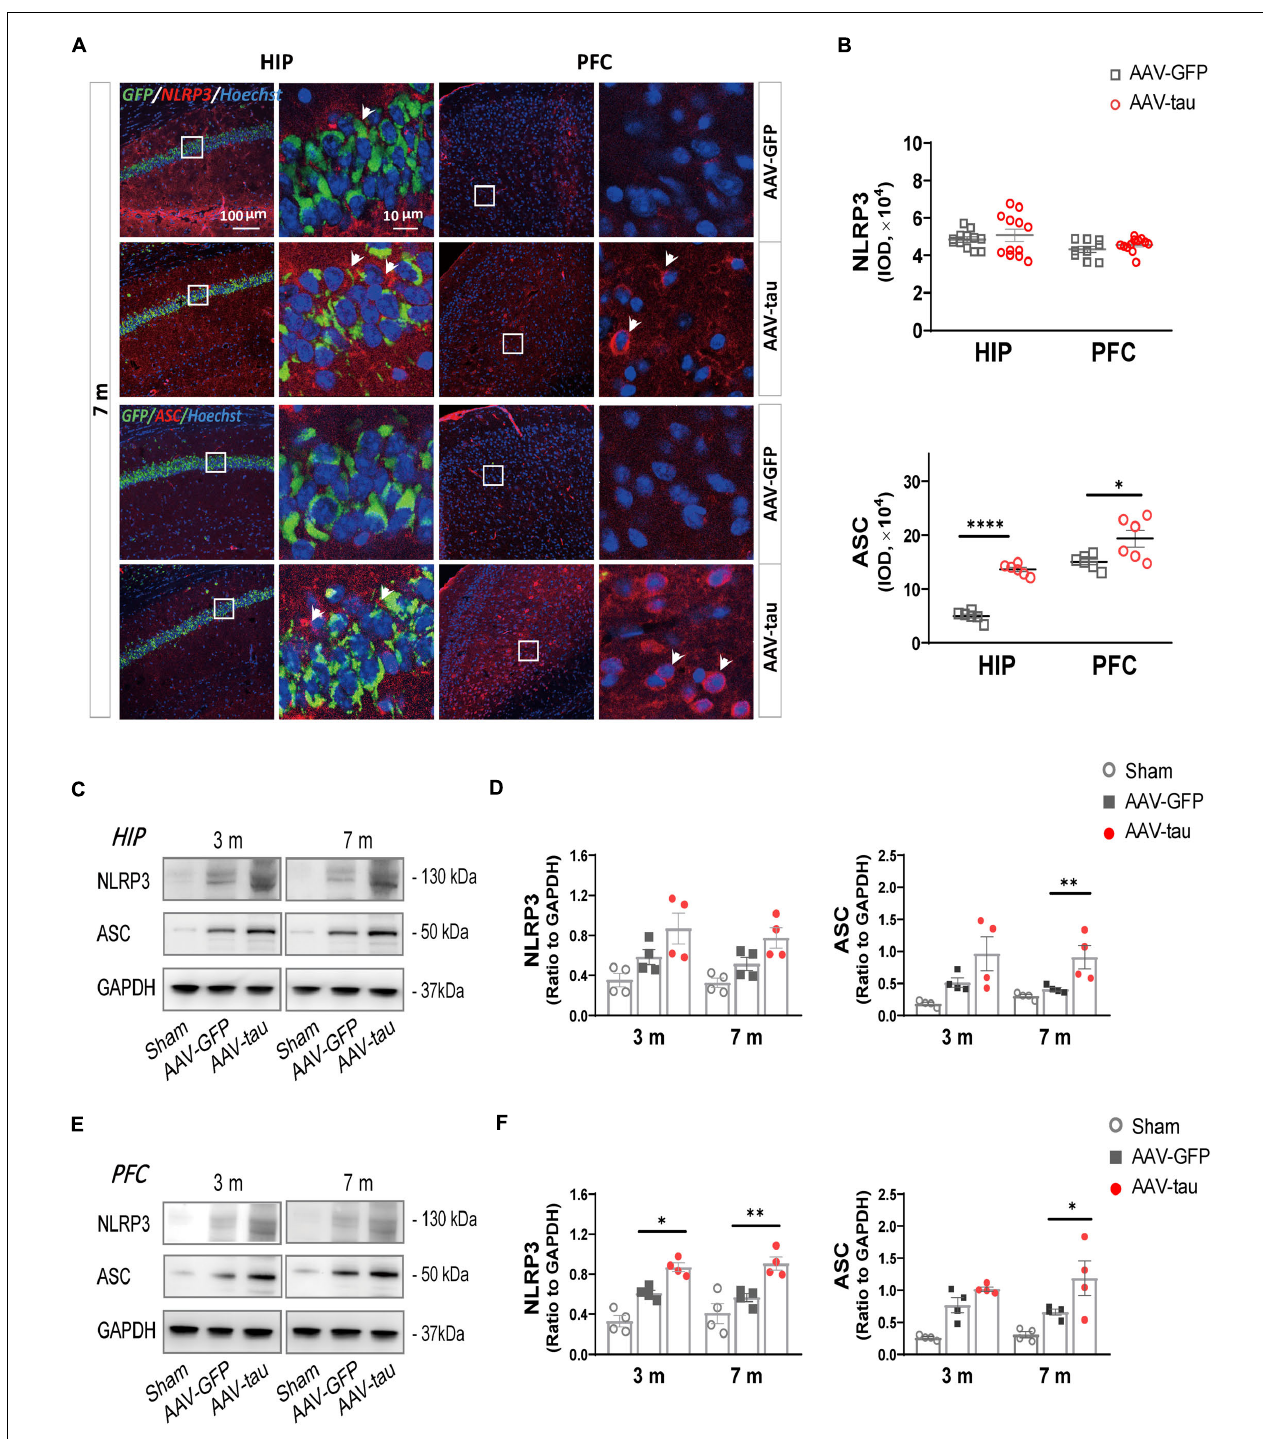
FIGURE 4 | Overexpression of p-tau caused elevations in ASC expression in the hippocampus and PFC. (A) Representative images of nucleotide-binding oligomerization domain (NOD)-like receptor pyrin domain-containing protein 3 (NLRP3) (red) and ASC (red) in the ipsilateral HIP and PFC taken from mice injected with AAV-tau or AAV-GFP 3 and 7 months after injection. White arrows indicate positive staining for NLRP3 or ASC. (B) Quantifications of NLRP3 (top) and ASC (bottom) immunoactivities shown in the previous panel (6–12 ROIs from three mice for every group). (C–F) Representative western blots of NLRP3 and ASC in the (C) ipsilateral HIP and (E) PFC, and quantifications of the immunoreactivities for NLRP3 (left) and ASC (right) in the (D) HIP and (F) PFC. Data were normalized to GAPDH, n = 4 per group. (D,F) Two-way ANOVA and (B) unpaired t -test were performed, ∗ p < 0.05, ∗∗ p < 0.01, ∗∗∗∗ p <